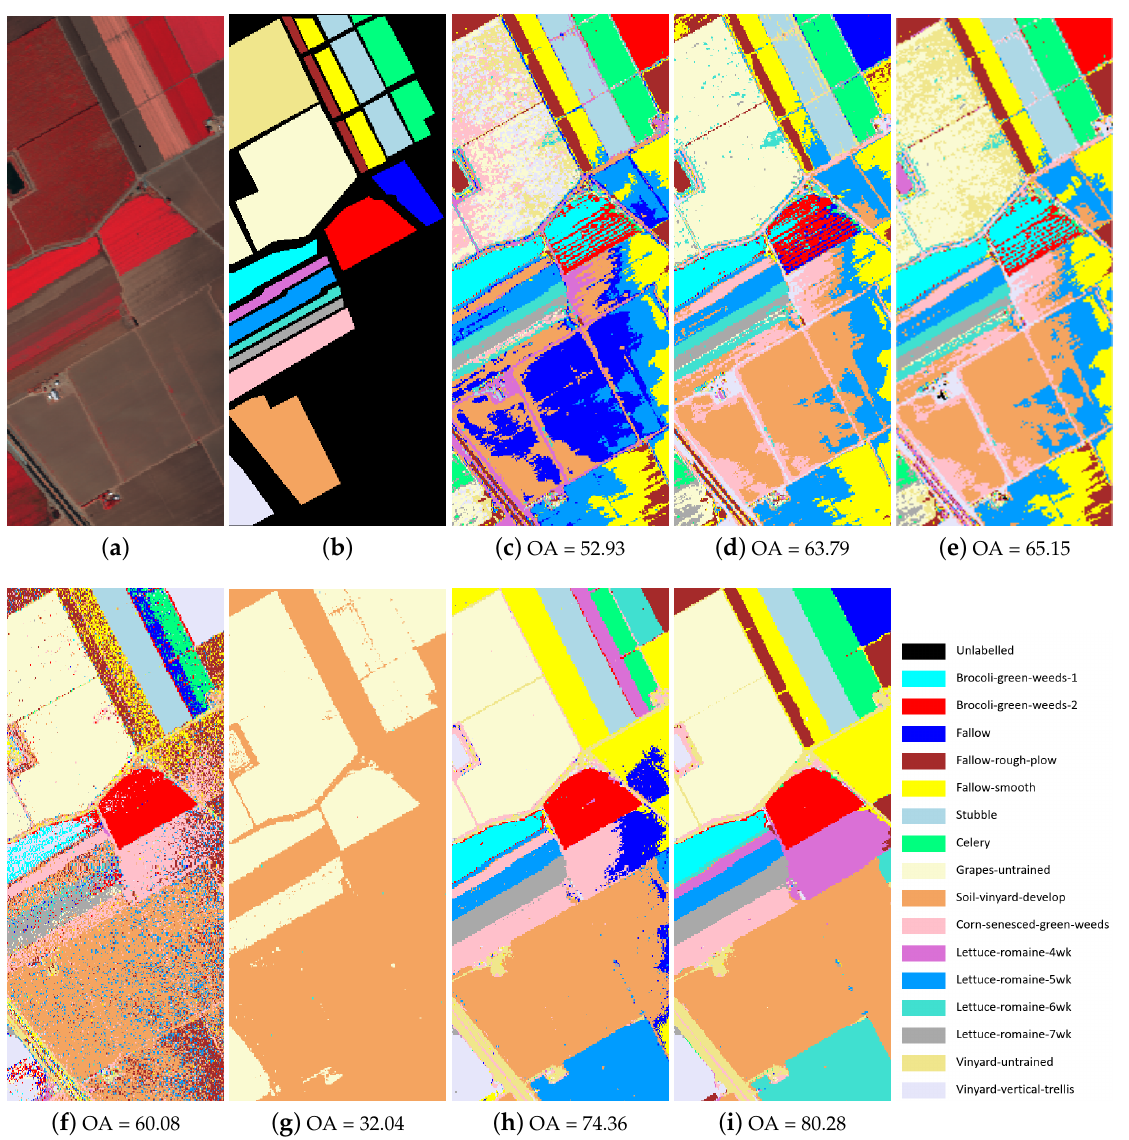
Figure 7. Salinas image. ( a ) False color image, ( b ) Ground truth, and Clustering maps of ( c ) FCM, ( d ) k-means, ( e ) RSC, ( f ) SSSC, ( g ) SSC-OMP, ( h ) Sketch-SSC and ( i )